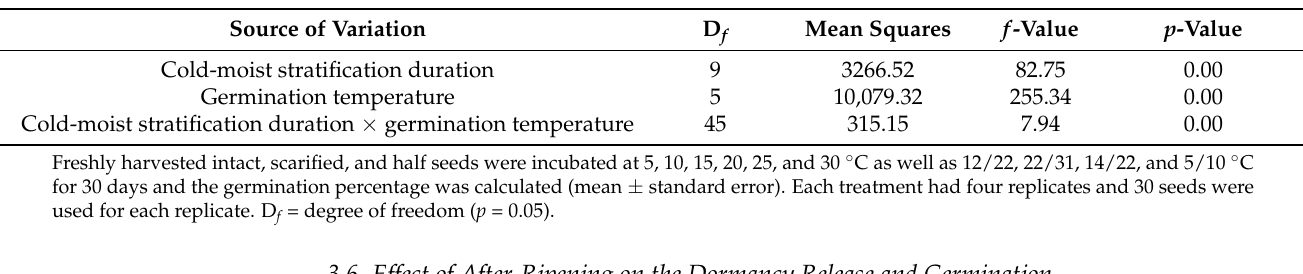
Table 3. Effects of cold-moist stratification duration and germination temperature and their interaction on the germination